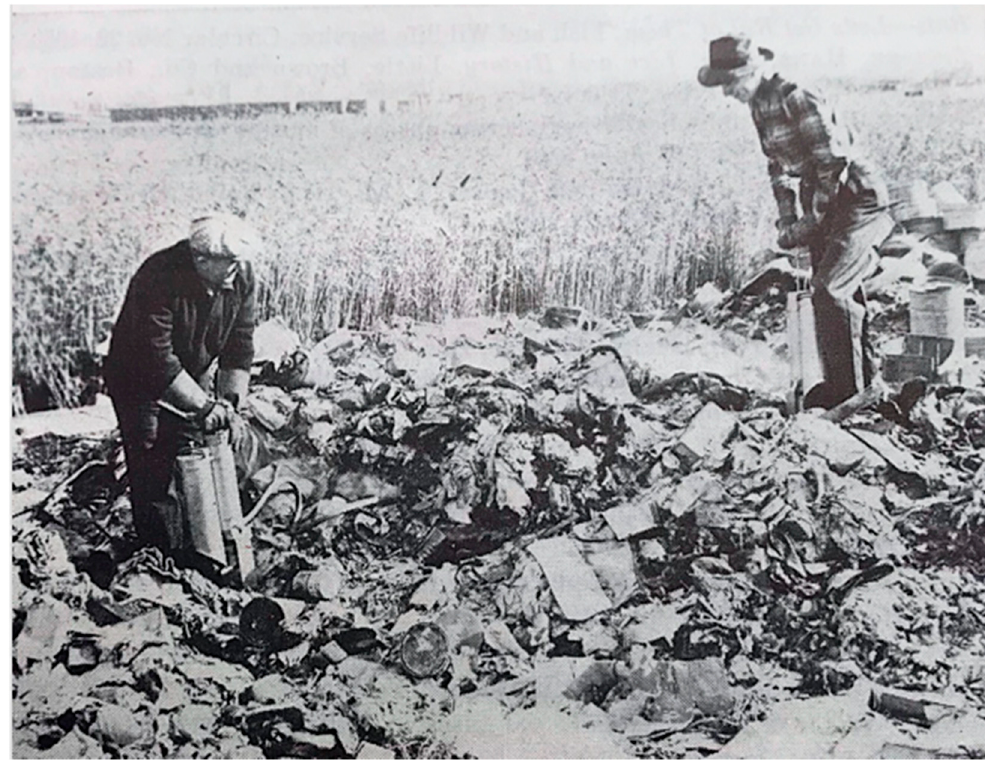
Figure 11. Men pumping calcium cyanide powder (Cyanogas TM ) into rat burrows at a city dump. This compound reacts with moisture and releases hydrogen cyanide gas [156].